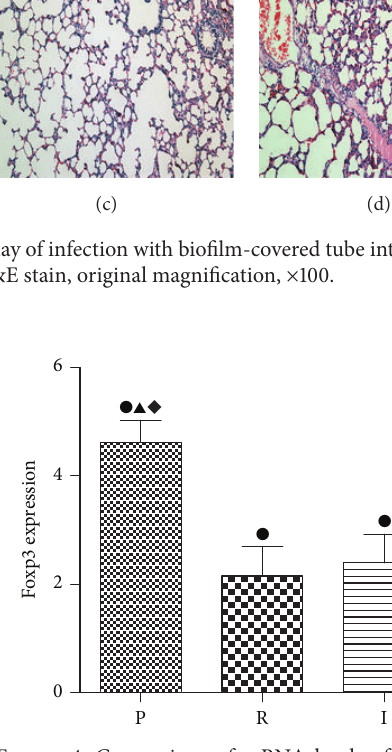
Figure 4: Comparison of mRNA levels of Foxp3 in lung tissues of four groups. PAO1 group (P), Δ lasI Δ rhlI group (I), Δ lasR Δ rhlR group (R), and control group (C). e : compared with control group, 𝑝 < 0.05 . 󳵳 : statistically significant differences between PAO1 and Δ lasR Δ rhlR group, 𝑝 < 0.05 . X : statistically significant differences between PAO1 and Δ lasI Δ rhlI group, 𝑝 < 0.05